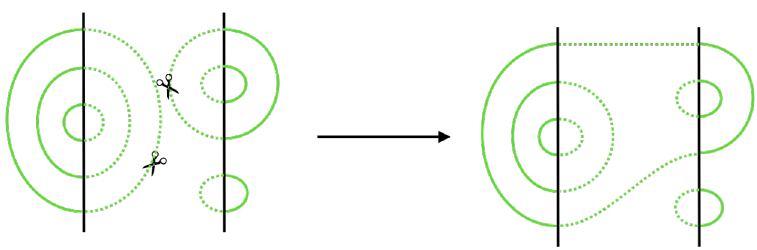
Figure 27 . The leading correction diagrams for h x | D ( h ) | y i in the k = 0 sector ( D ( h ) shown as dashed lines in the middle) is constructed by starting with mirroring the x and y link states (shown as solid lines on the left and right sides). Then an outer strand is cut on both mirrored link states before connecting them to form D ( h ) . This construction decreases the contribution of such diagram by one order of χ compared to | x y |